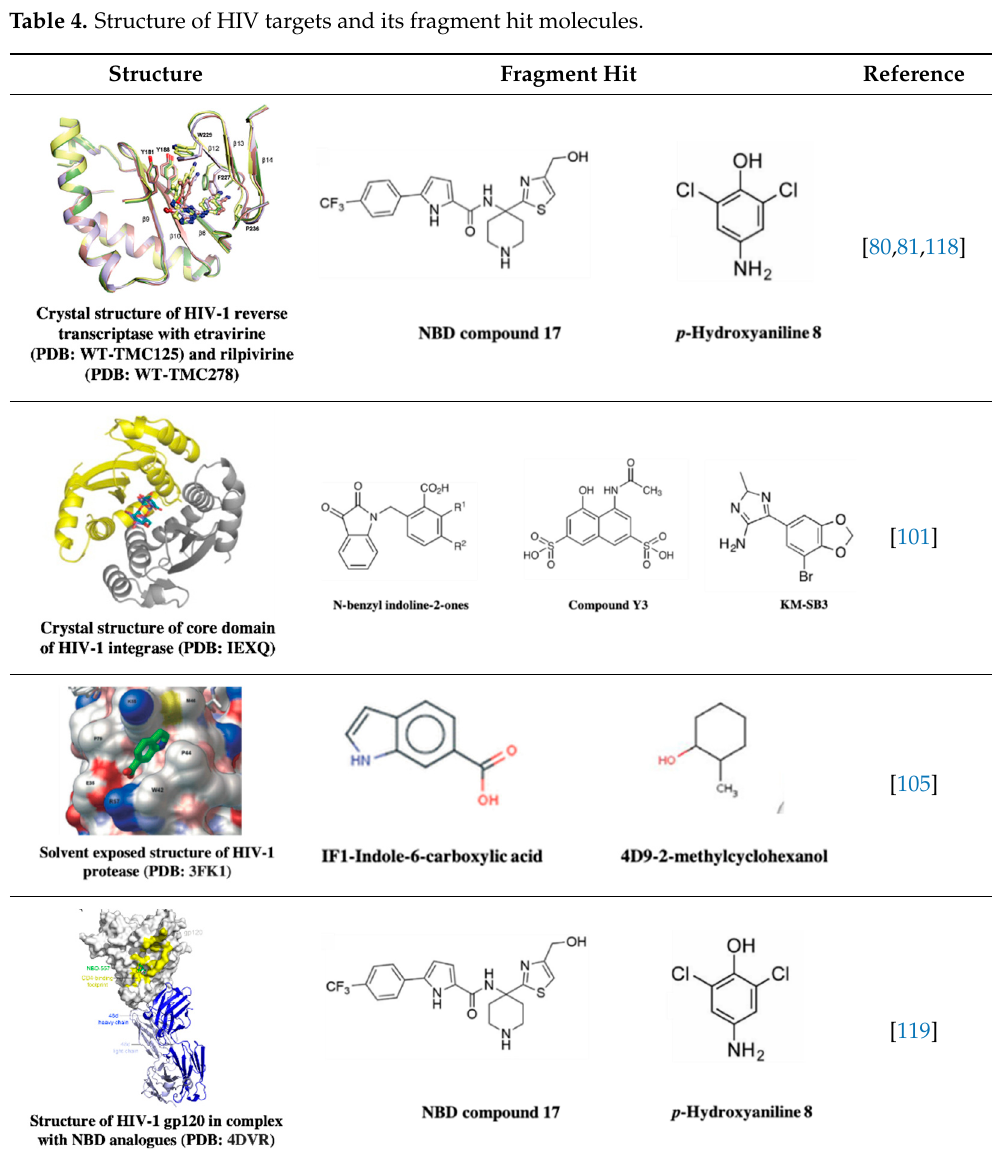
Table 4. Structure of HIV targets and its fragment hit molecules.